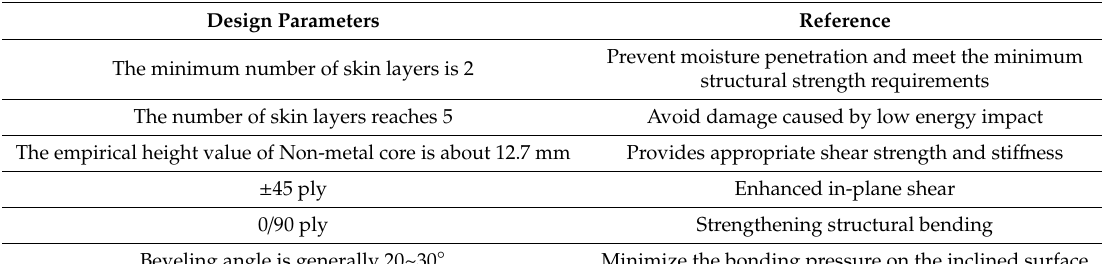
Table 4. The design basis of